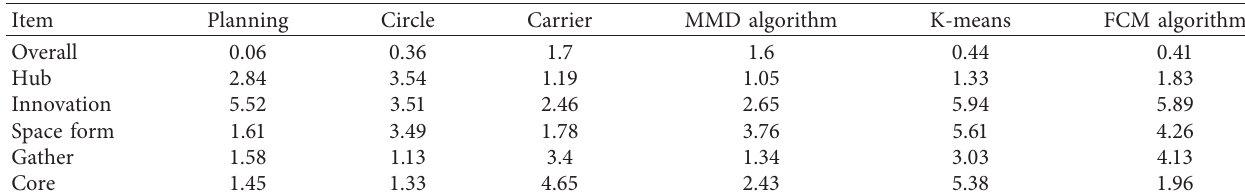
Figure 3: The relationship between high-speed railway financing and economic development. Table 5: The overall planning of innovation resources.